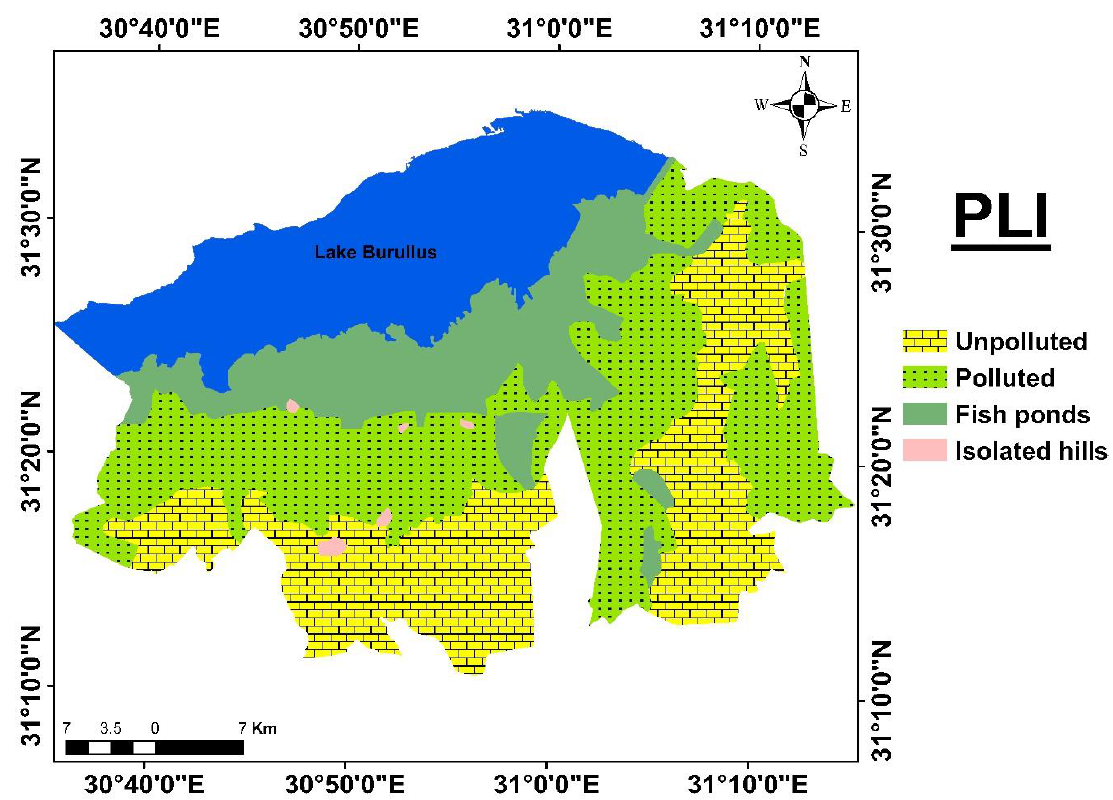
Figure 5. Pollution load indices (PLI) in the studied